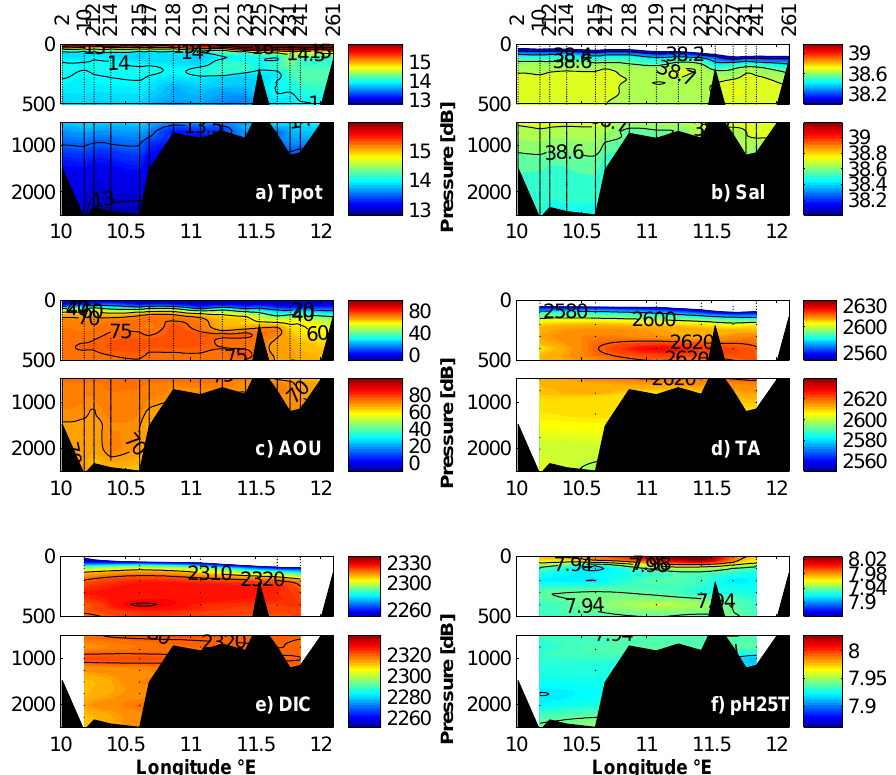
Fig. 8. Vertical distributions across the Sardinia Sicily passage using EF11 data of (a) potential temperature ( ◦ C), (b) salinity, (c) Apparent Oxygen Utilisation (AOU,µmolkg − 1 ) , (d) TA (µmolkg − 1 ) (e) DIC (µmolkg − 1 ) and (f) pH25T. Potential temperature, salinity and AOU are derived from CTD data, CTD-oxygen was calibrated with bottle data.